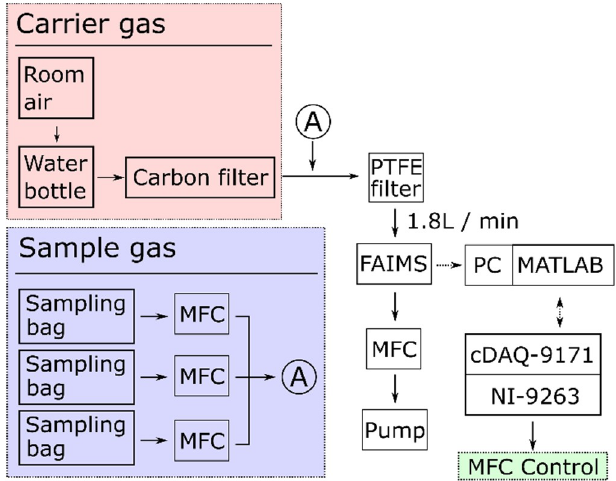
Figure 2. Block diagram of the measurement system.